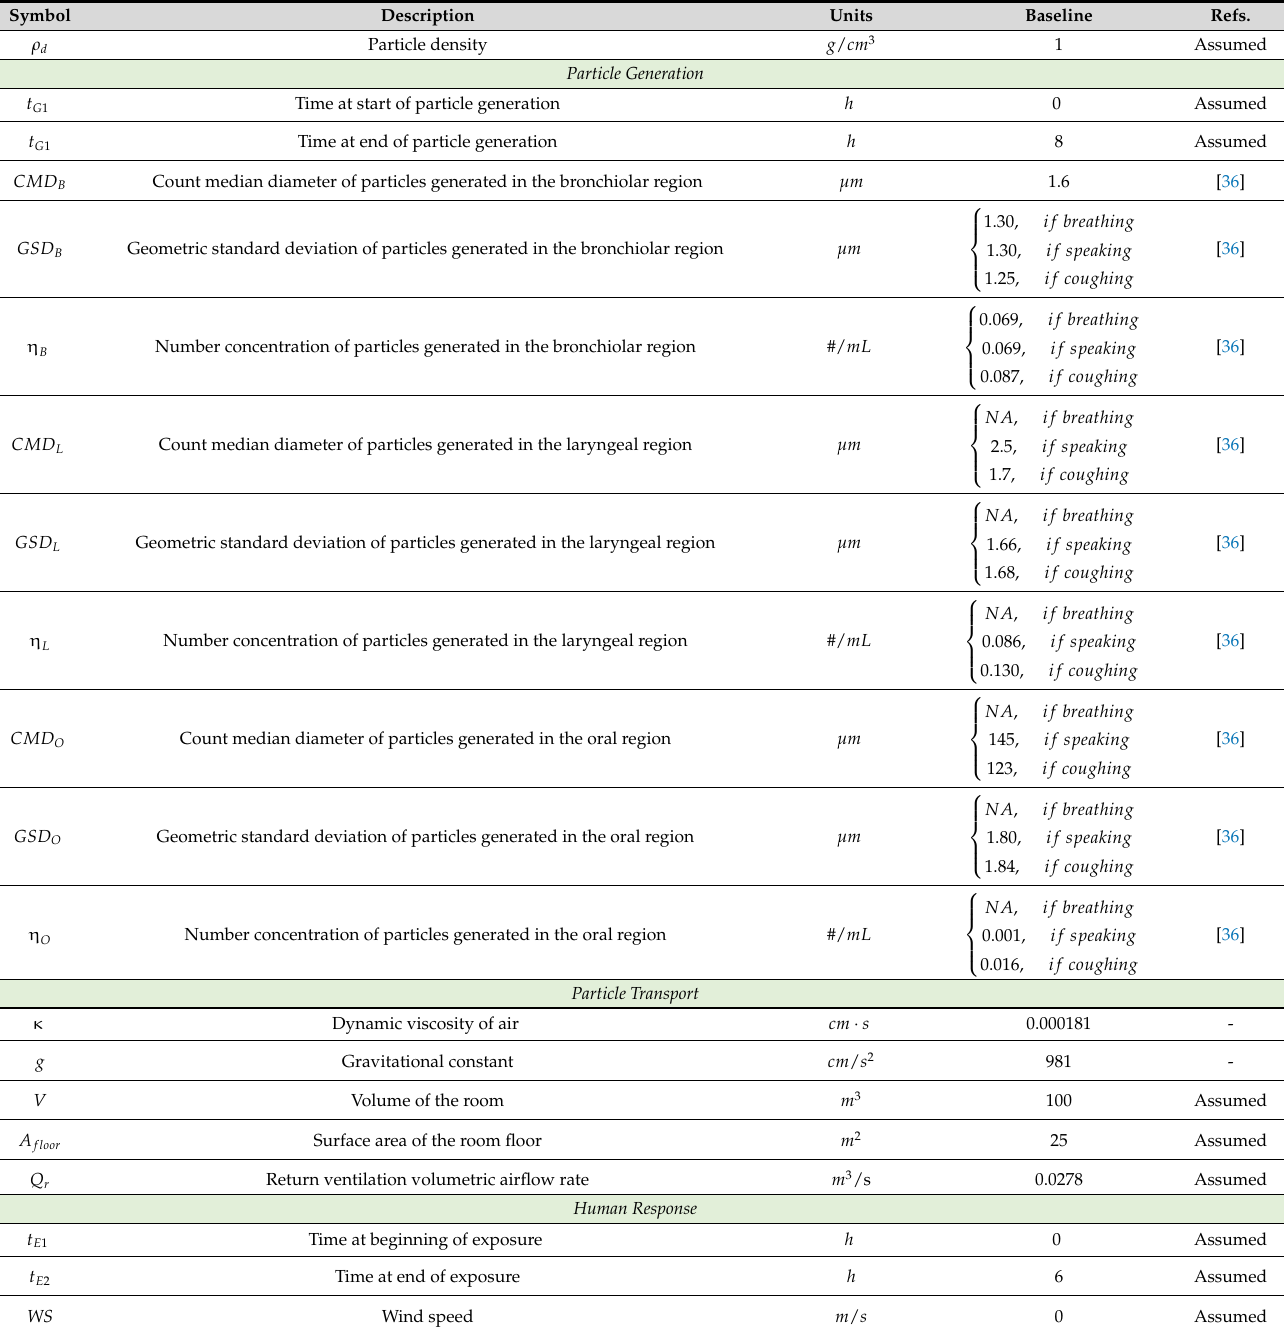
Table 1. Parameters and values used for baseline